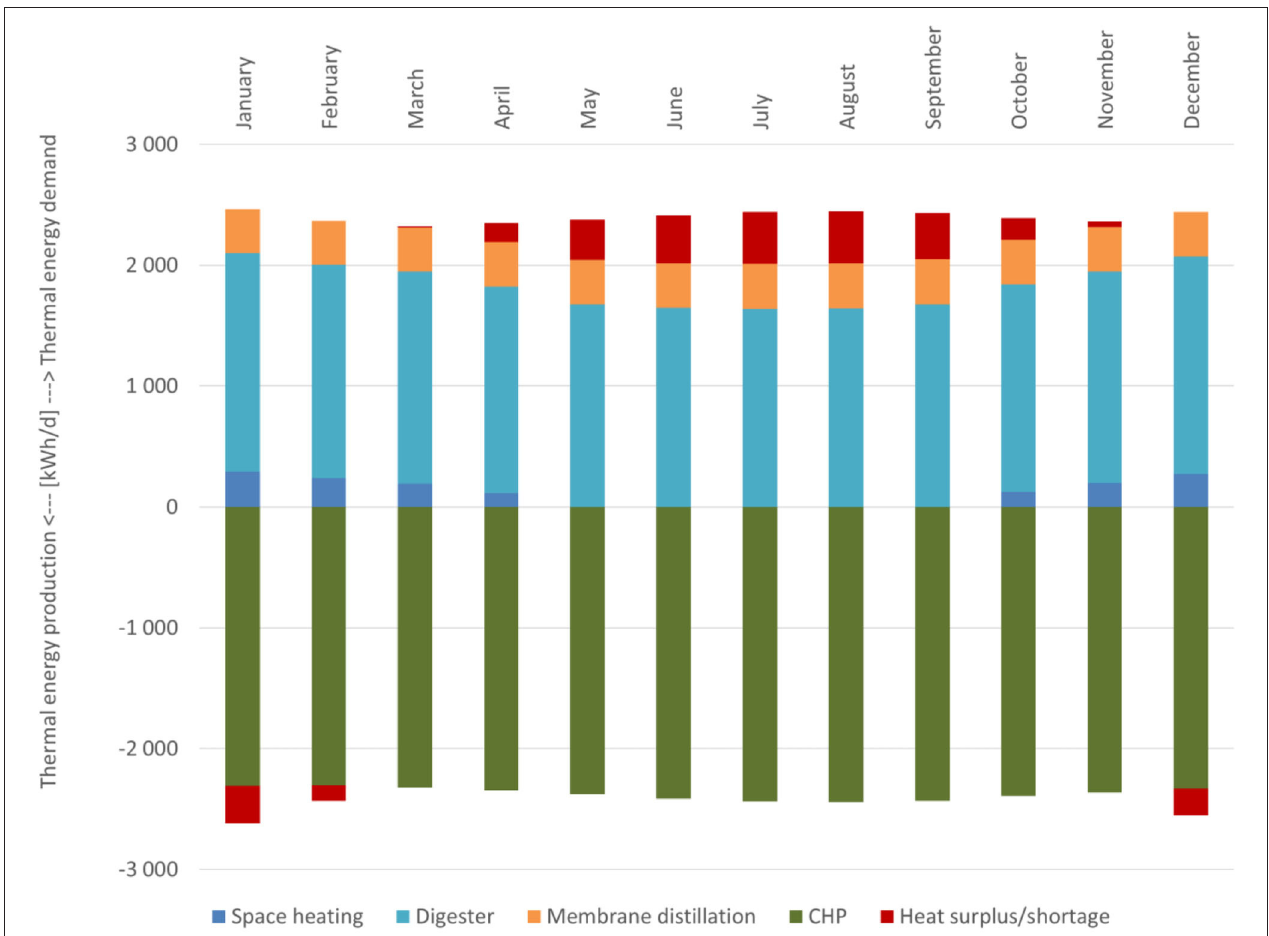
FIGURE 5 | Thermal energy balance of reference scenario. Above x -axis … thermal energy demand [kWh/d]. Below x -axis … thermal energy production [kWh/d]. Heat surplus/shortage indicates imbalances.